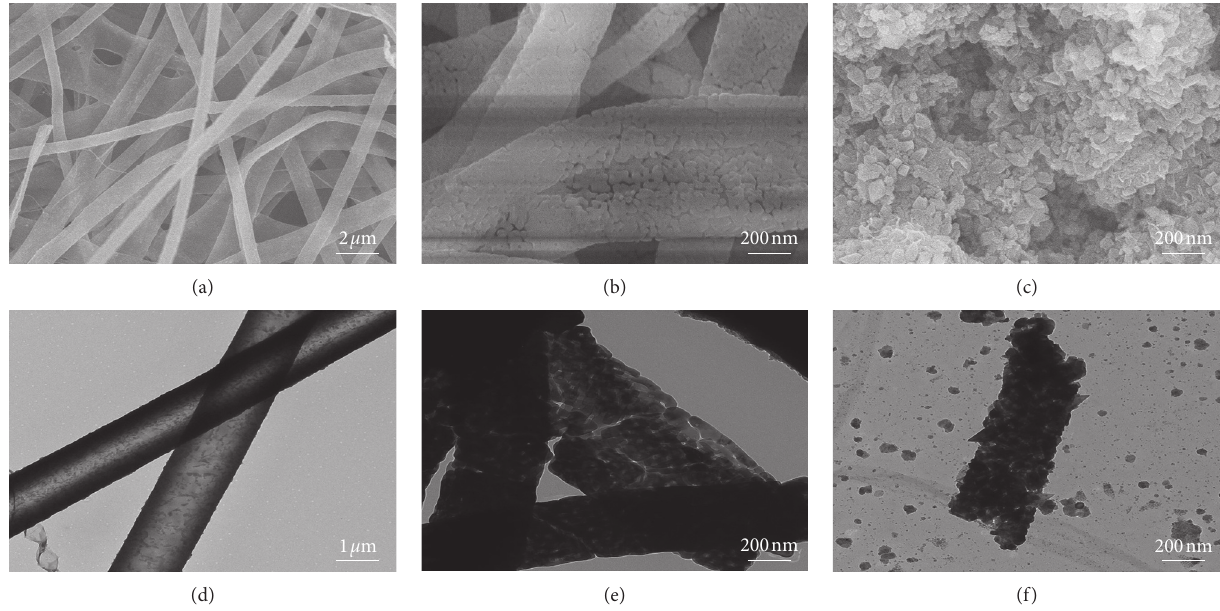
Figure 1: SEM images of (a) nanofibers before calcination, (b) porous SrTiO 3 NFs, and (c) SrTiO 3 @MoS 2 composite nanofibers. TEM images of (d) nanofibers before calcination, (e) porous SrTiO 3 NFs, and (f) SrTiO 3 @MoS 2 composite